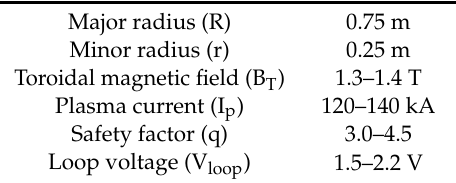
Table 1. Aditya-U plasma and machine